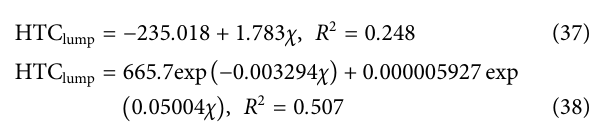
Frontiers in Materials |